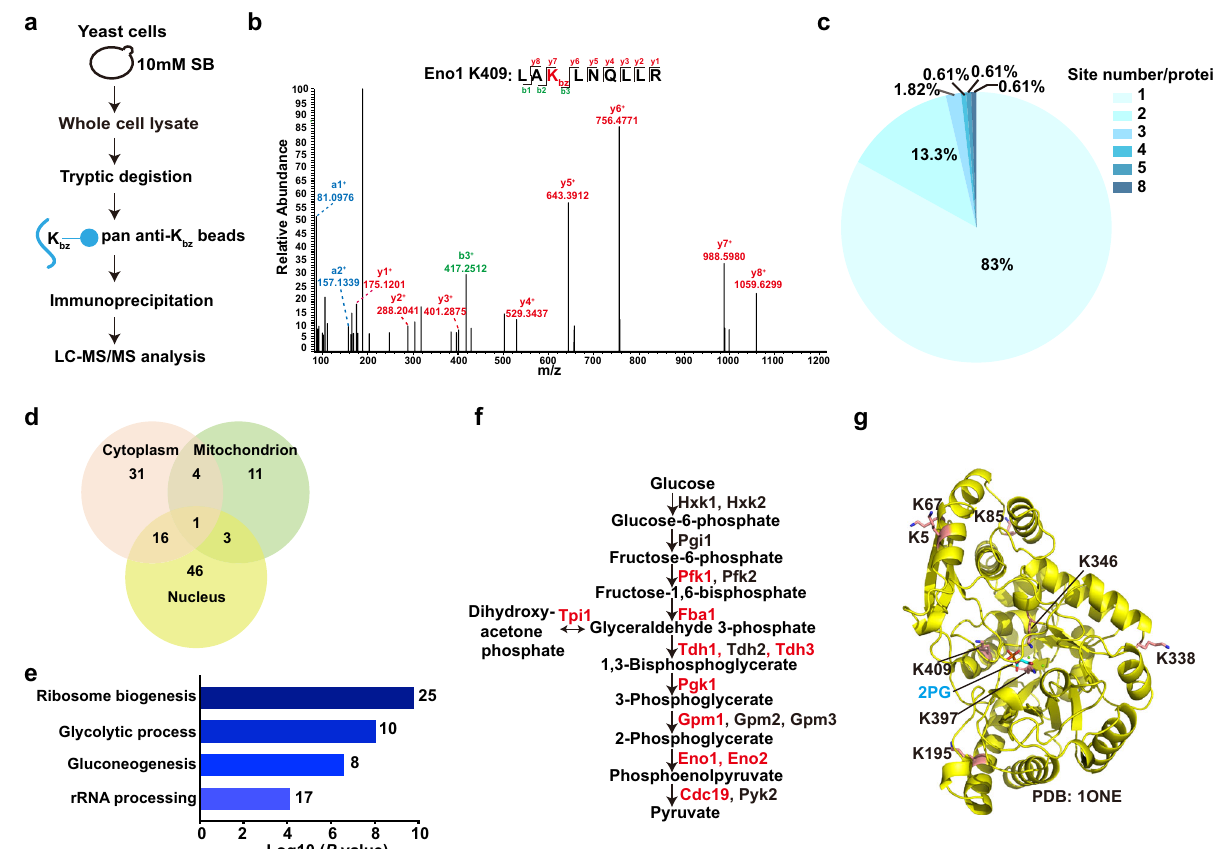
Fig. 7 Proteome-wide screening of Kbz-modi fi ed proteins in yeast cells. a The work fl ow used for HPLC – MS/MS-based non-histone Kbz sites identi fi cation in S. cerevisiae . b The MS/MS spectrum of an Eno1 peptide (LAK + 104.0268 LNQLLR) harboring one benzoylated site. Predicted y- and b-type ions are listed above and below the peptide sequence, respectively. Matched ions are labeled in the spectra. c Distribution of non-histone Kbz sites based on the site number per protein. d Venn diagram showing the subcellular compartment distribution of non-histone Kbz proteins. e Gene ontology analysis associated with signi fi cant regulated genes ( P < 0.05) of non-histone Kbz proteins. P values are derived from one-sided Fisher ’ s exact test. f Overview of glycolysis pathway. The enzymes with identi fi ed benzoylation sites are shown in red. g Eight benzoylation sites on Eno1 are shown in the structural model of Eno1 (PDB: 1ONE). The Eno1 substrate, 2-phosphoglycerate, is shown in cyan. K346, K397, and K409 are adjacent to the substrate-binding